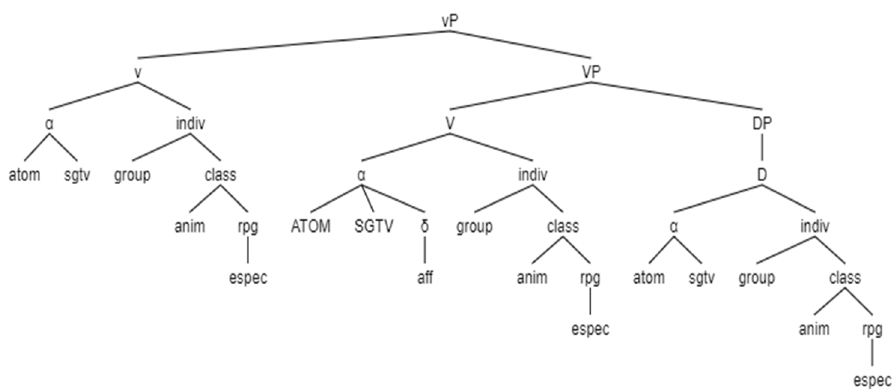
Figure 9. The general geometry of D, V, and v.